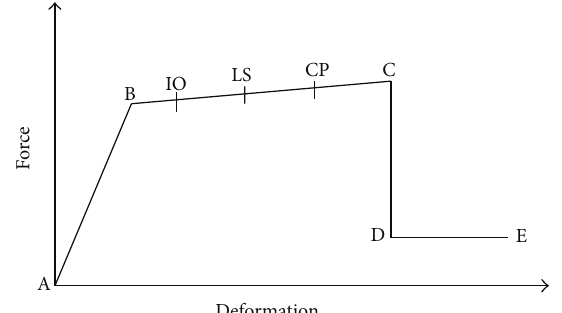
Figure 5: Force-deformation relationship of a plastic hinge.